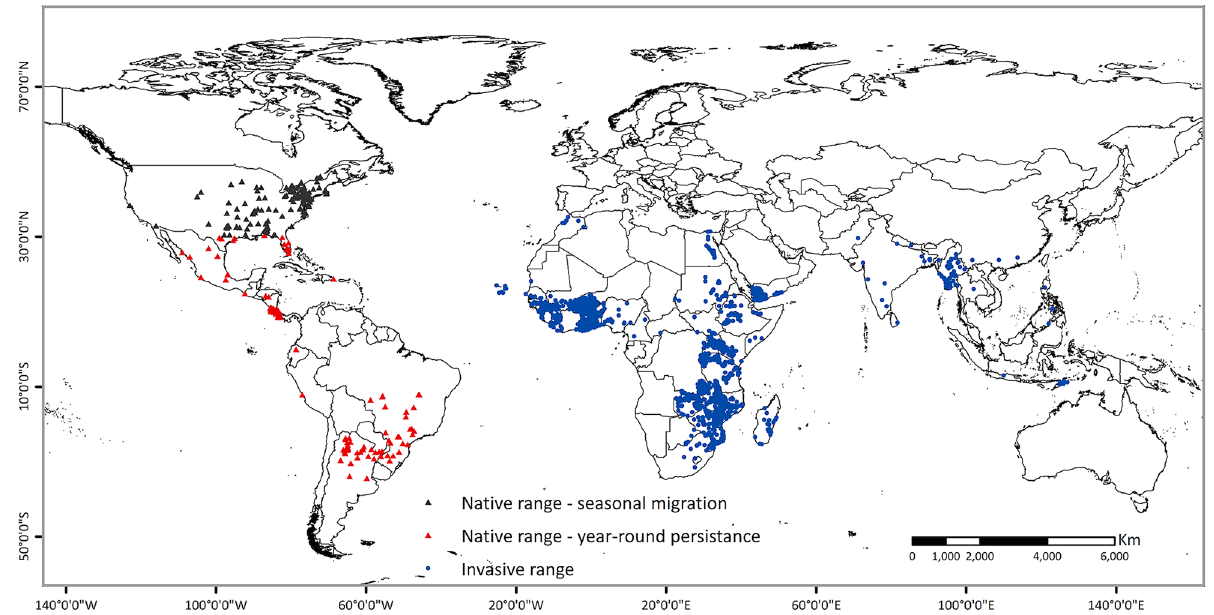
Figure 1. FAW presence confirmed locations in the world. Triangles represent FAW occurrence records from its native range—black triangles show areas that support seasonal population growth and red triangles show areas that support year-round population establishment. Blue circles show FAW occurrence records from its invasive range. ArcMap 10.8 (https:// deskt op. arcgis. com/ en/